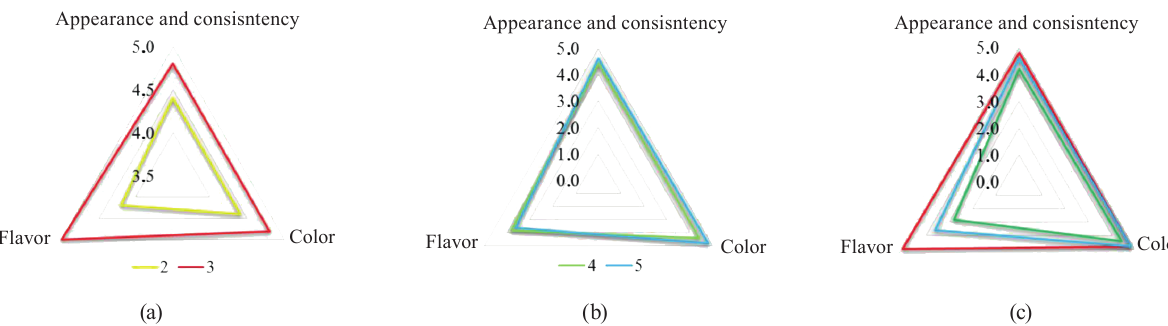
Figure 7 Sensory evaluation of the cottage cheese: (a) formulations 2 and 3; (b) formulations 4 and 5; (c) control formulation 1 and formulations 3 and 5, which proved